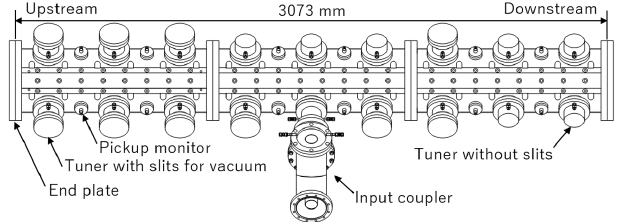
FIG. 8. Side view of the cavity with high-power tuners and a high-power coupler.